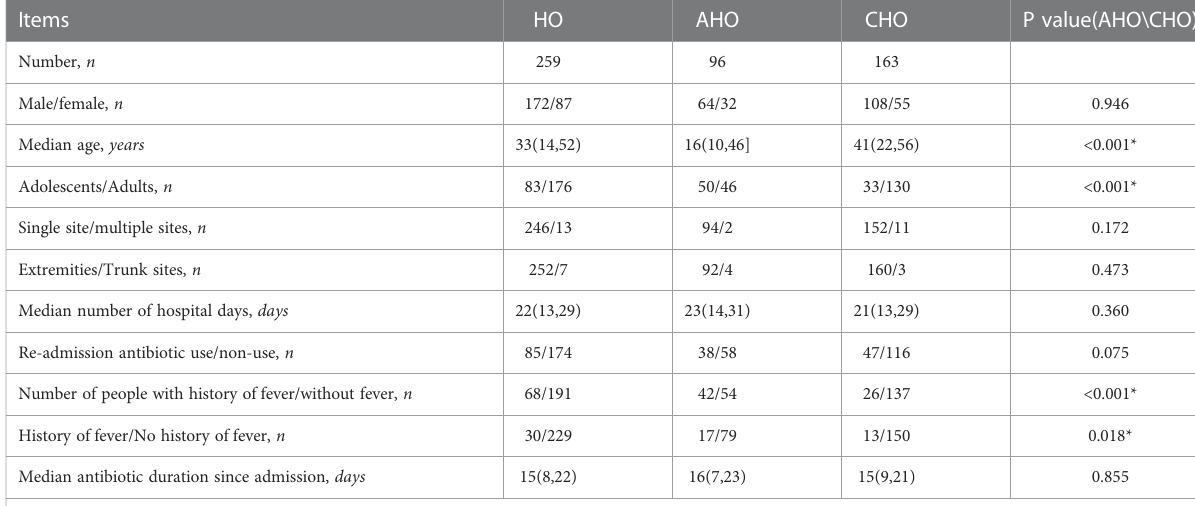
TABLE 1 Baseline